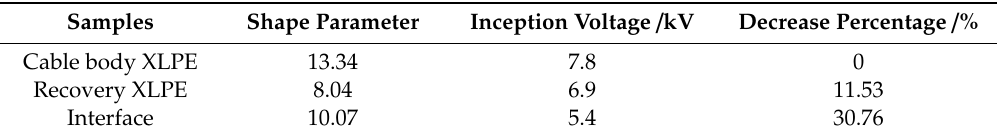
Figure 6. Weibull two-parameter statistics of electrical-tree inception voltages for cable body, recovery insulation, and their interface. Table 1. The characteristic electrical-tree inception voltages in 63.2% probability and shape parameters of Weibull distributions fitted in 95% confidence interval.